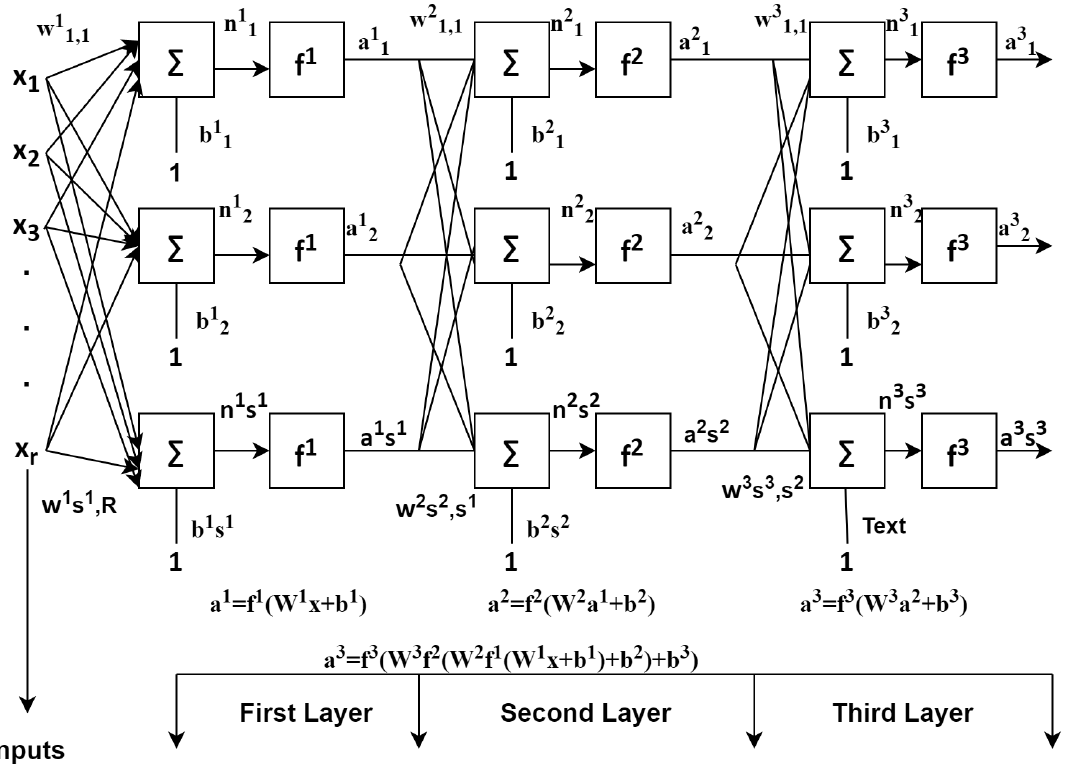
Figure 3. Feed forward neural